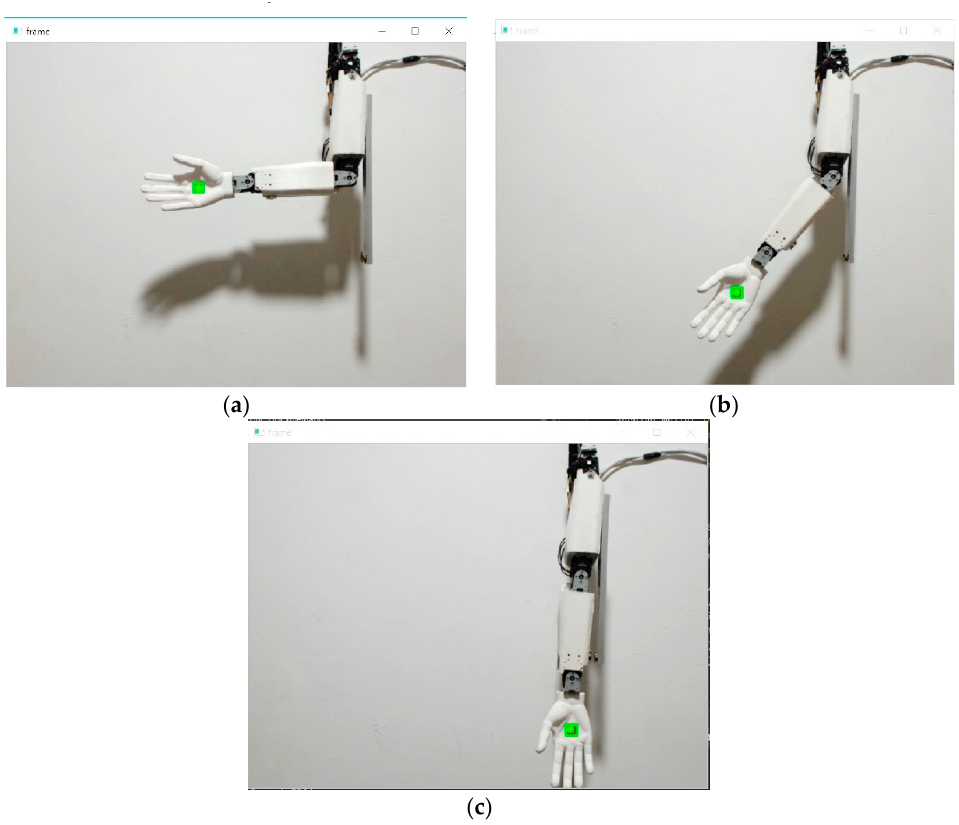
Figure 14. Identification of the trajectory: ( a ) capture at 90°, ( b ) capture at 45°, ( c ) capture at 0°.